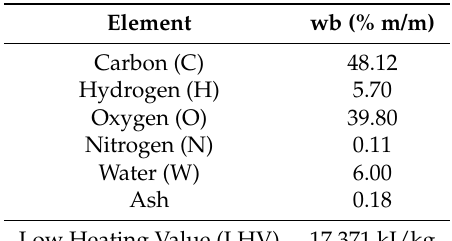
Table 1. Characteristics of pellet adopted during